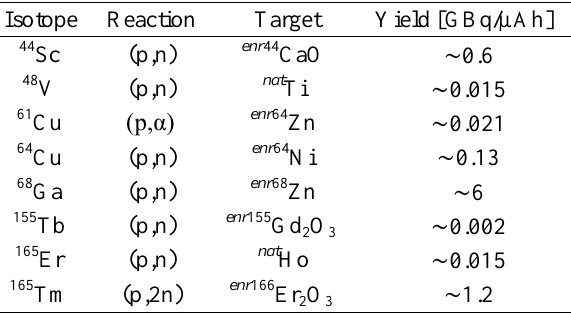
Fig. 2. (a) The Hyperloop system connected to the STS. (b) The IBA Nirta solid target station and the solid target transfer system by TEMA Sinergie. A shuttle is visible in the inset. (c) The receiving station located in the BTL bunker.